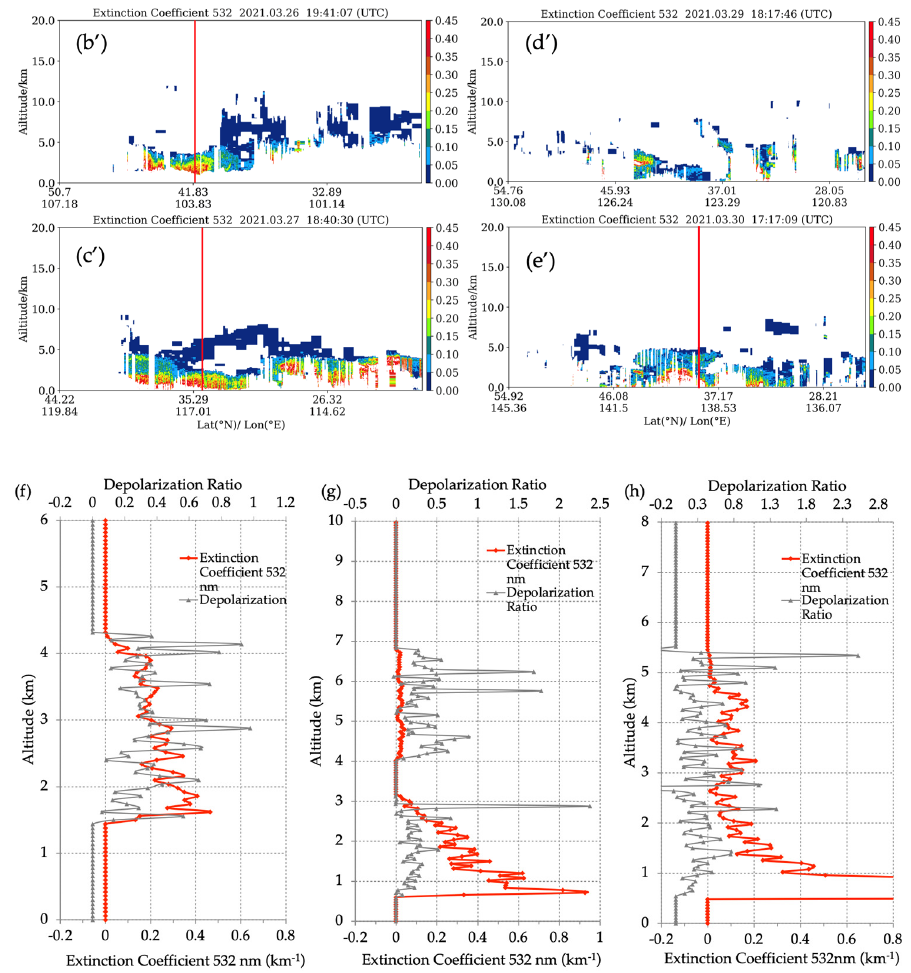
Figure 5. Illustration of 3 · 28 dust event transport path, originating in GD on 26 March and transported to the Sea of Japan on 30 March. ( a ) The vertical cross-section of the aerosol subtype overlapping the CALIPSO orbit; ( b – e ) The cross-section of the CALIOP depolarization ratio on 26, 27, 29, and 30 March 2021, respectively; ( b ’– e ’) The cross-section of the CALIOP extinction coefficient 532 nm on 26, 27, 29, and 30 March 2021, respectively; ( f – h ) The vertical profile distribution of the extinction coefficient 532 nm and the depolarization ratio for the three positions labeled by red line, position correspondence: ( f – b , b ’), ( g – c , c ’), ( h – e , e ’).